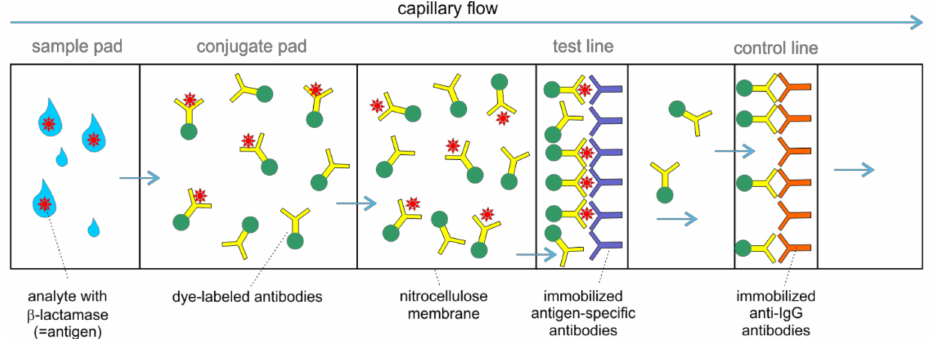
Figure 4. Basic principle of lateral flow assays. Schematic illustration of different zones of commer- cially available lateral flow assays for detection of, i.e., β -lactamases. Antigens within the sample migrate along the nitrocellulose membrane by capillary flow. Antigens (e.g., β -lactamase) conjugate with specific dye-labeled antibodies and are captured by immobilized antigen-specific antibodies, resulting in the visualization of the test line. Non-conjugated and unbound antibodies migrate further to the control line and are captured by immobilized anti-IgG antibodies, resulting in the visibility of a control